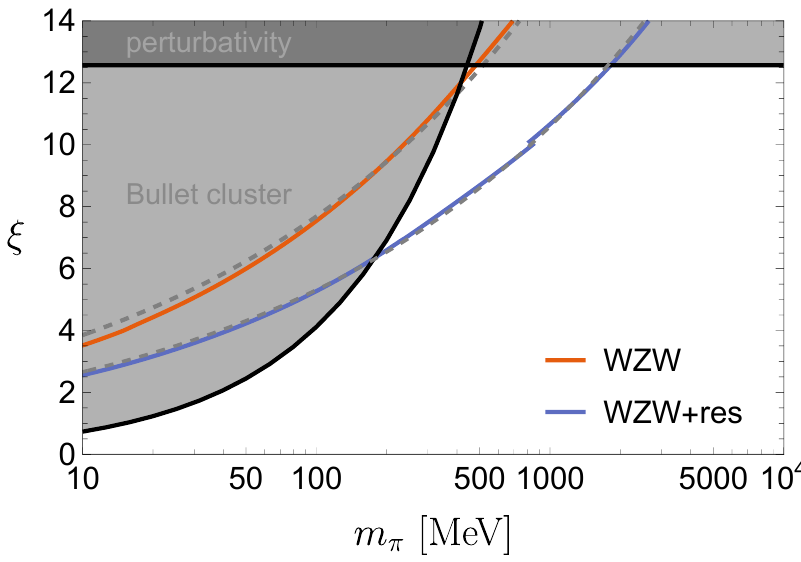
Figure 1. Relic density constraint on ξ for different values of the dark pion mass for the WZW-term only (red), and including the resonance via the dark photon (blue). The dashed lines correspond to the estimate of eq. (4.9) (setting α d = 0 for the WZW estimate). The gray shaded areas are excluded by ξ > 4 π , where the χ PT description breaks down, and the Bullet cluster bound on the DM self-interaction σ/m ≤ 1 cm 2 / g . All lines are for N f = N c = 3 .